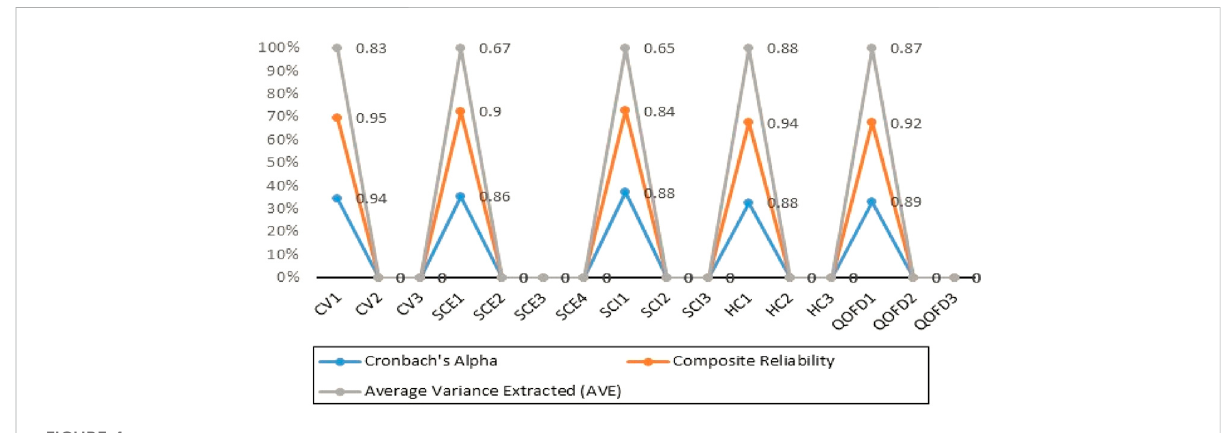
FIGURE 4 Indicates convergent validity and reliability test.